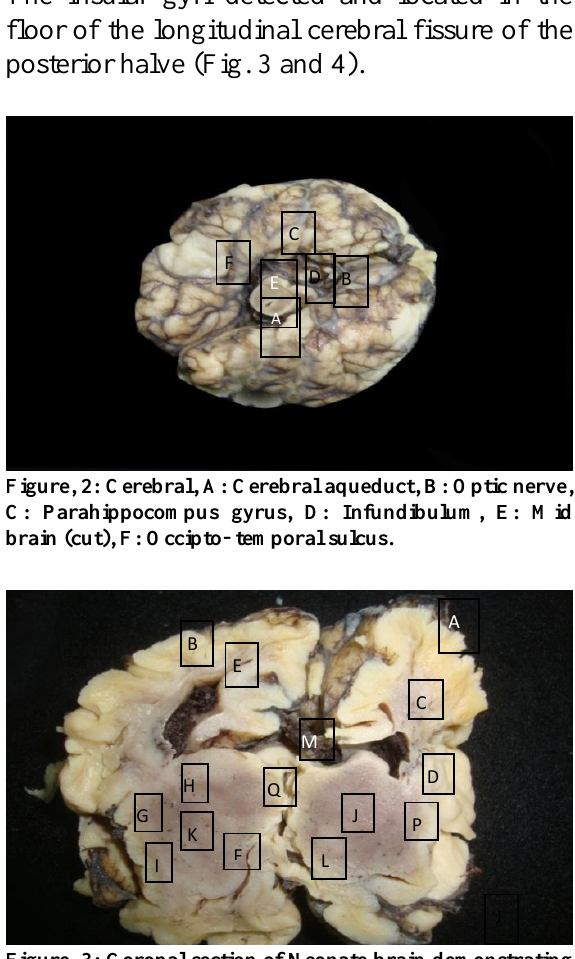
Figure, 3: Coronal section of Neonate brain demonstrating the following:- A: Pia matter, B: Gray matter, C: White matter, D: Insular cortex, E: Anterior horn of lateral ventricle, F: Posterior horn of lateral ventricle, G: Lentiform nucleus, H: Globus pallidus, K: Putamen), I: External capsule, L: Internal capsule, J: Thalamus, Q: Septum pellucidum, P: Claustrum, M: Coroid plexus.